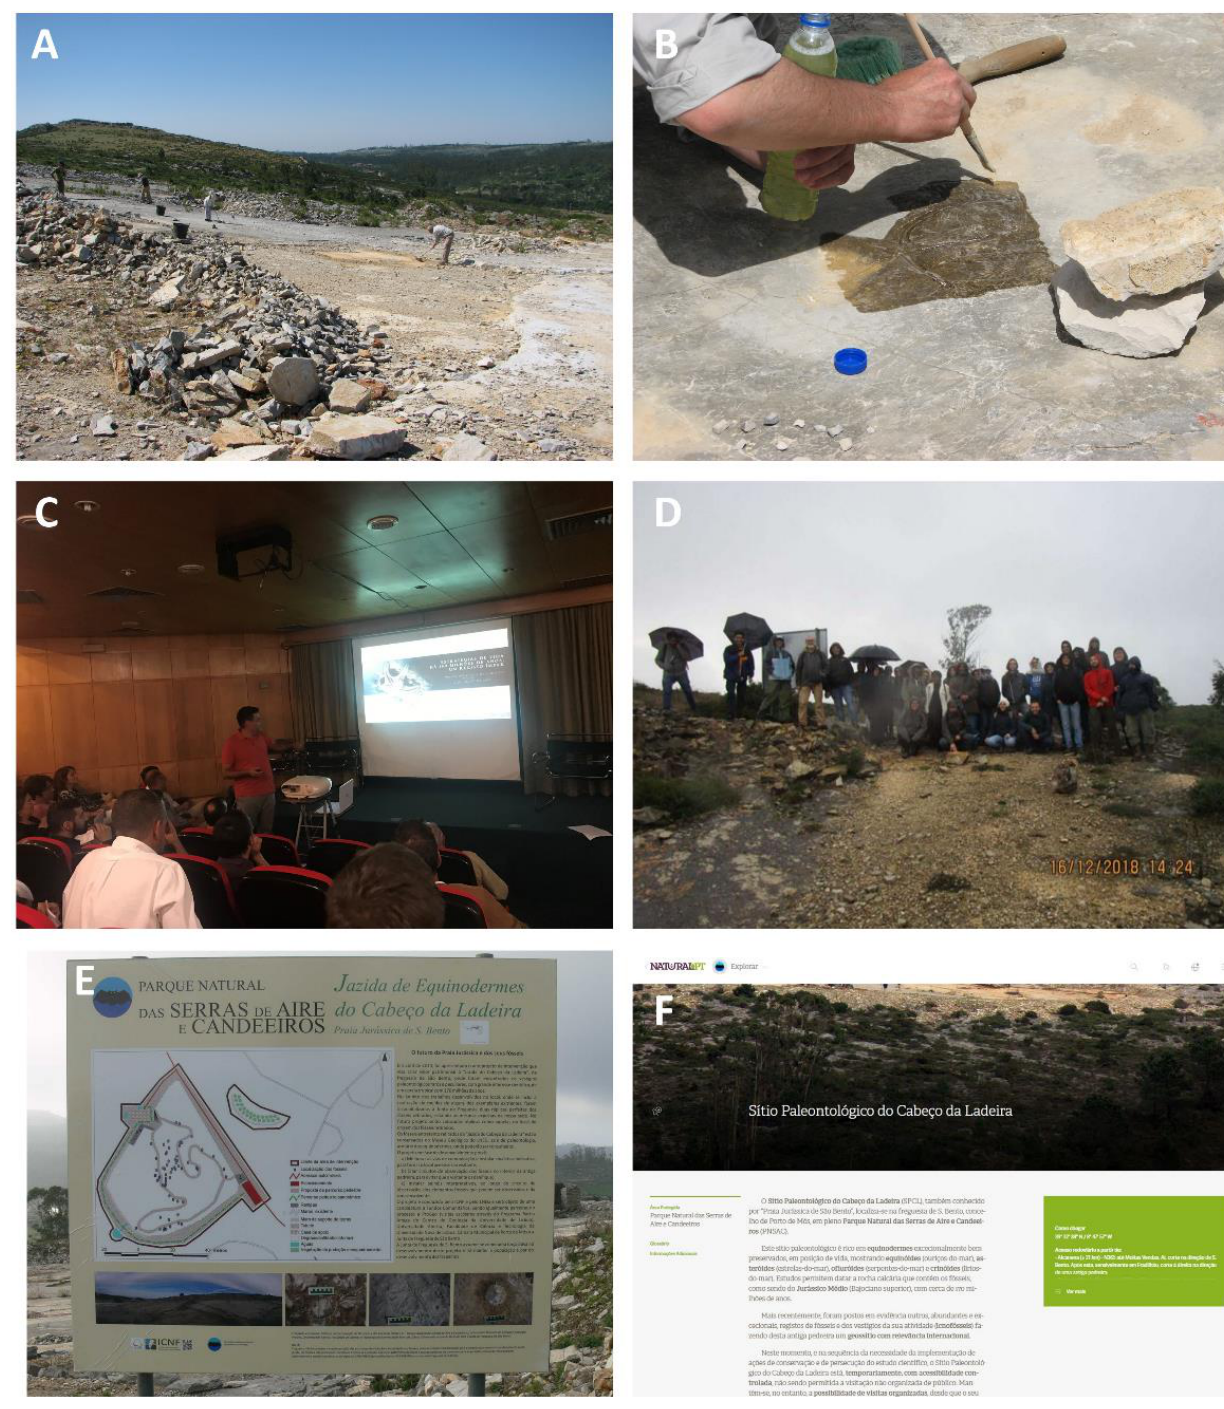
Figure 8. Conservation and outreach actions at the Cabeço da Ladeira geosite (photos from the authors): ( A ) cleaning of the surface; ( B ) execution of casts; ( C ) workshop session at Porto de Mós open to local communities; ( D ) paleontology field trip for students from the Faculty of Sciences, University of Lisbon; ( E ) explanatory panel at the site; and ( F ) internet site at Natural.pt (ICNF).